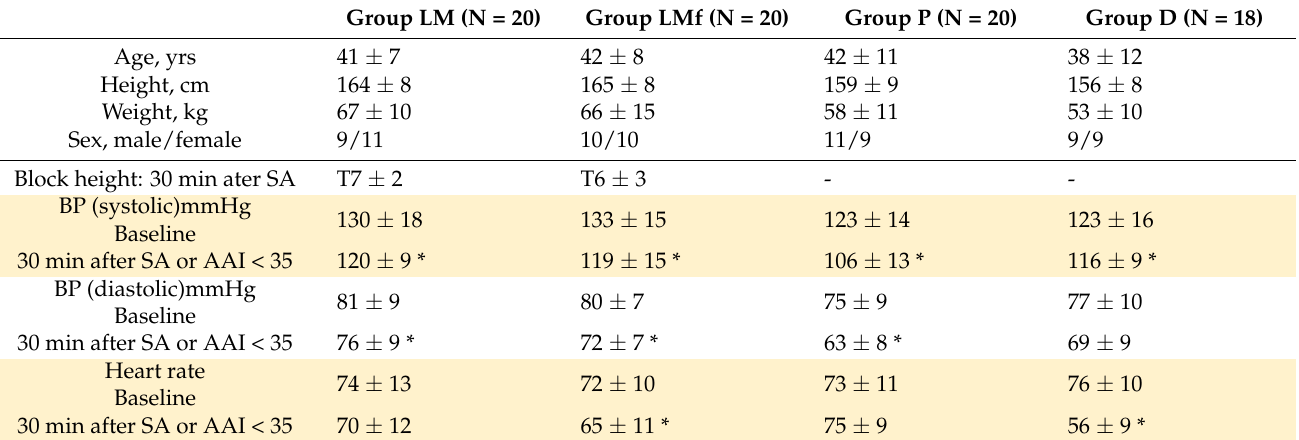
Table 1. Demography, hemodynamic baseline and postanesthesia